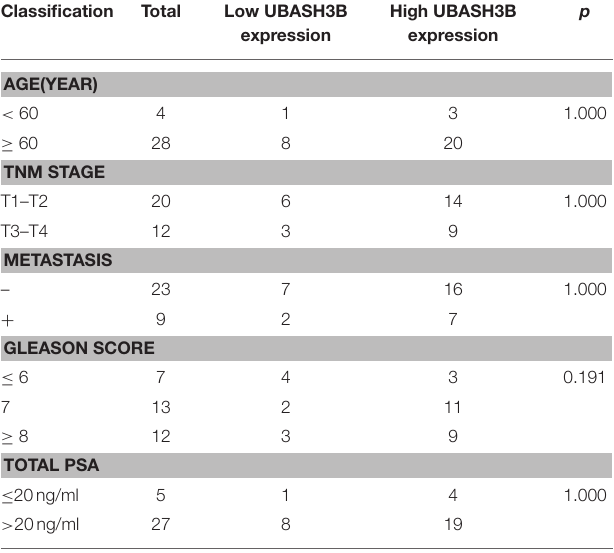
TABLE 1 | Relationship between UBASH3B expression level and clinicopathological variables and in prostate cancer patients.